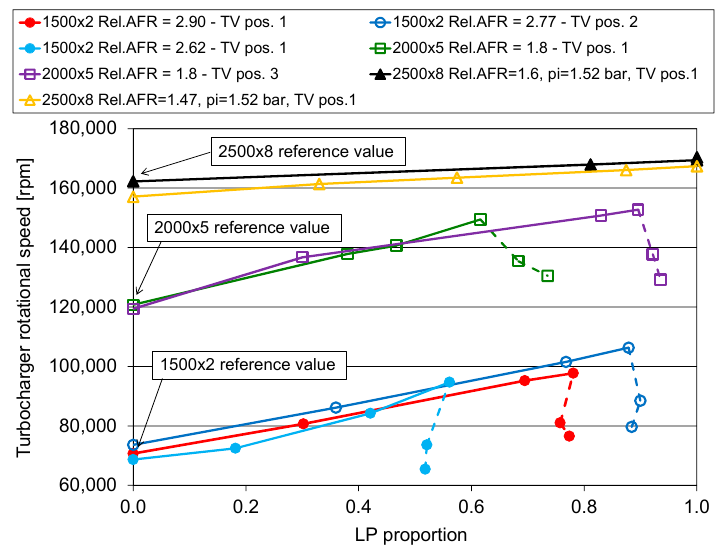
Figure 11. Turbocharger rotational speed as a function of LP proportion in different operating modes.